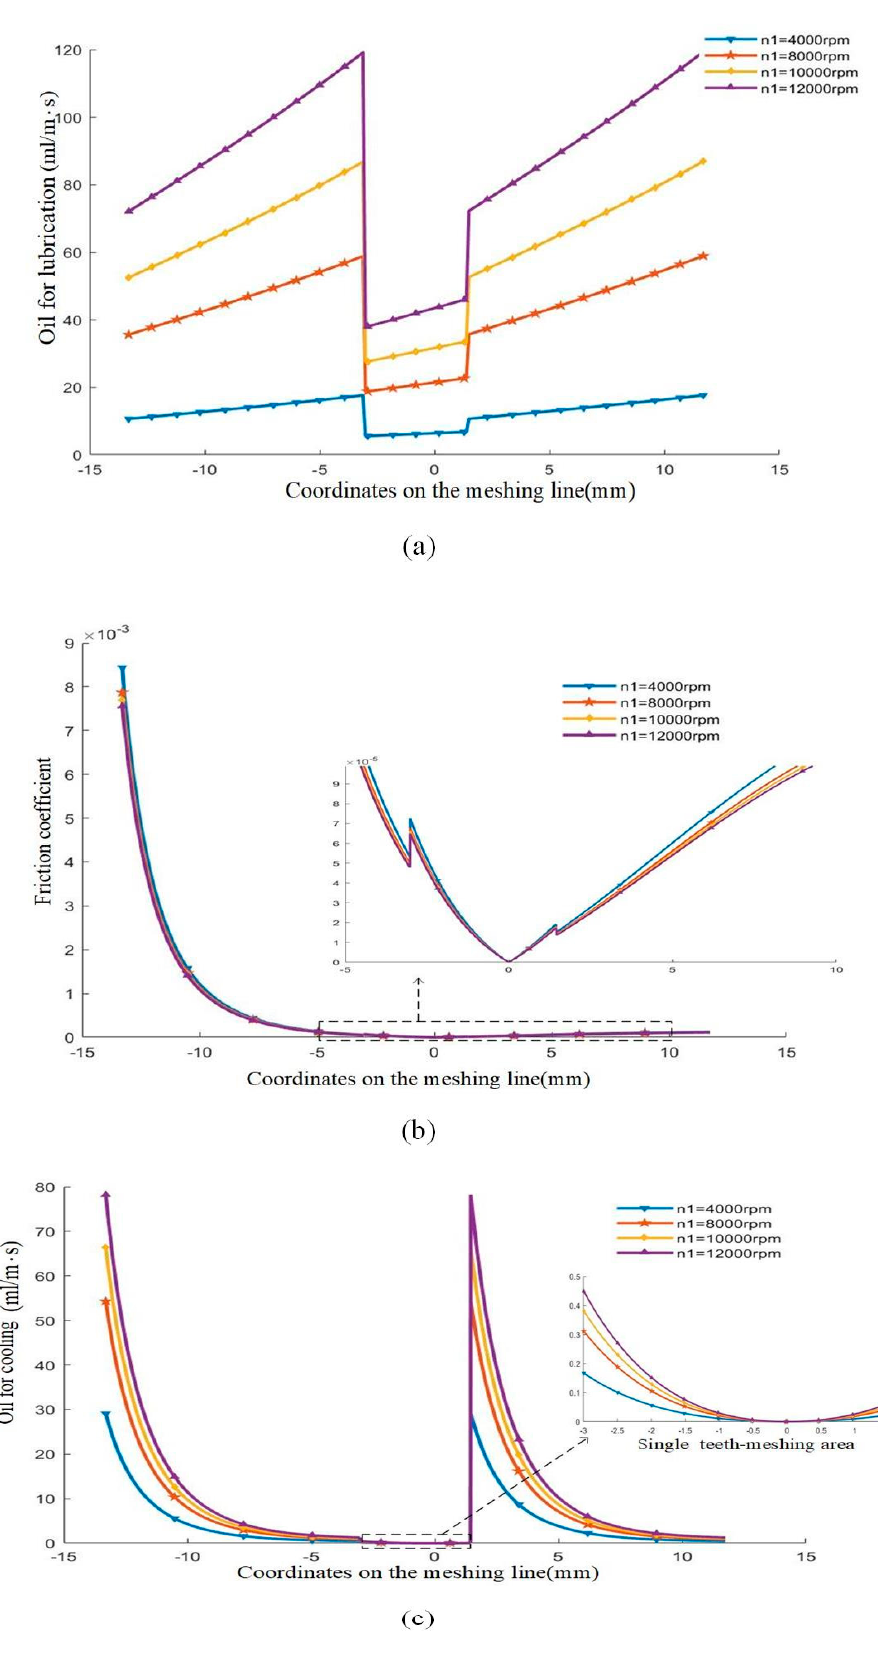
Figure 9. Oil volume for lubrication ( a ), friction coefficient ( b ) and oil volume for cooling ( c ) at different input speeds during the meshing process.